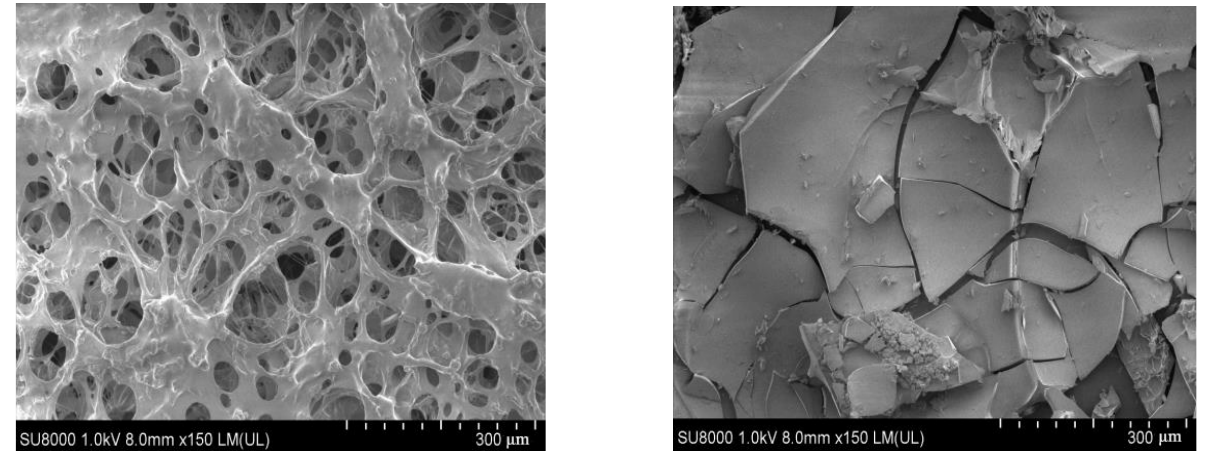
Figure 6. SEM Comparison of Common Chrome Gel (Left) and Novel Naphthol Gel (Right).